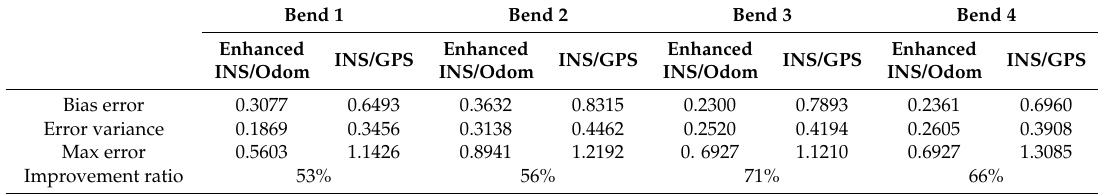
Table 3. Experimental results of the enhanced INS/Odo and INS/GPS methods for four bends.